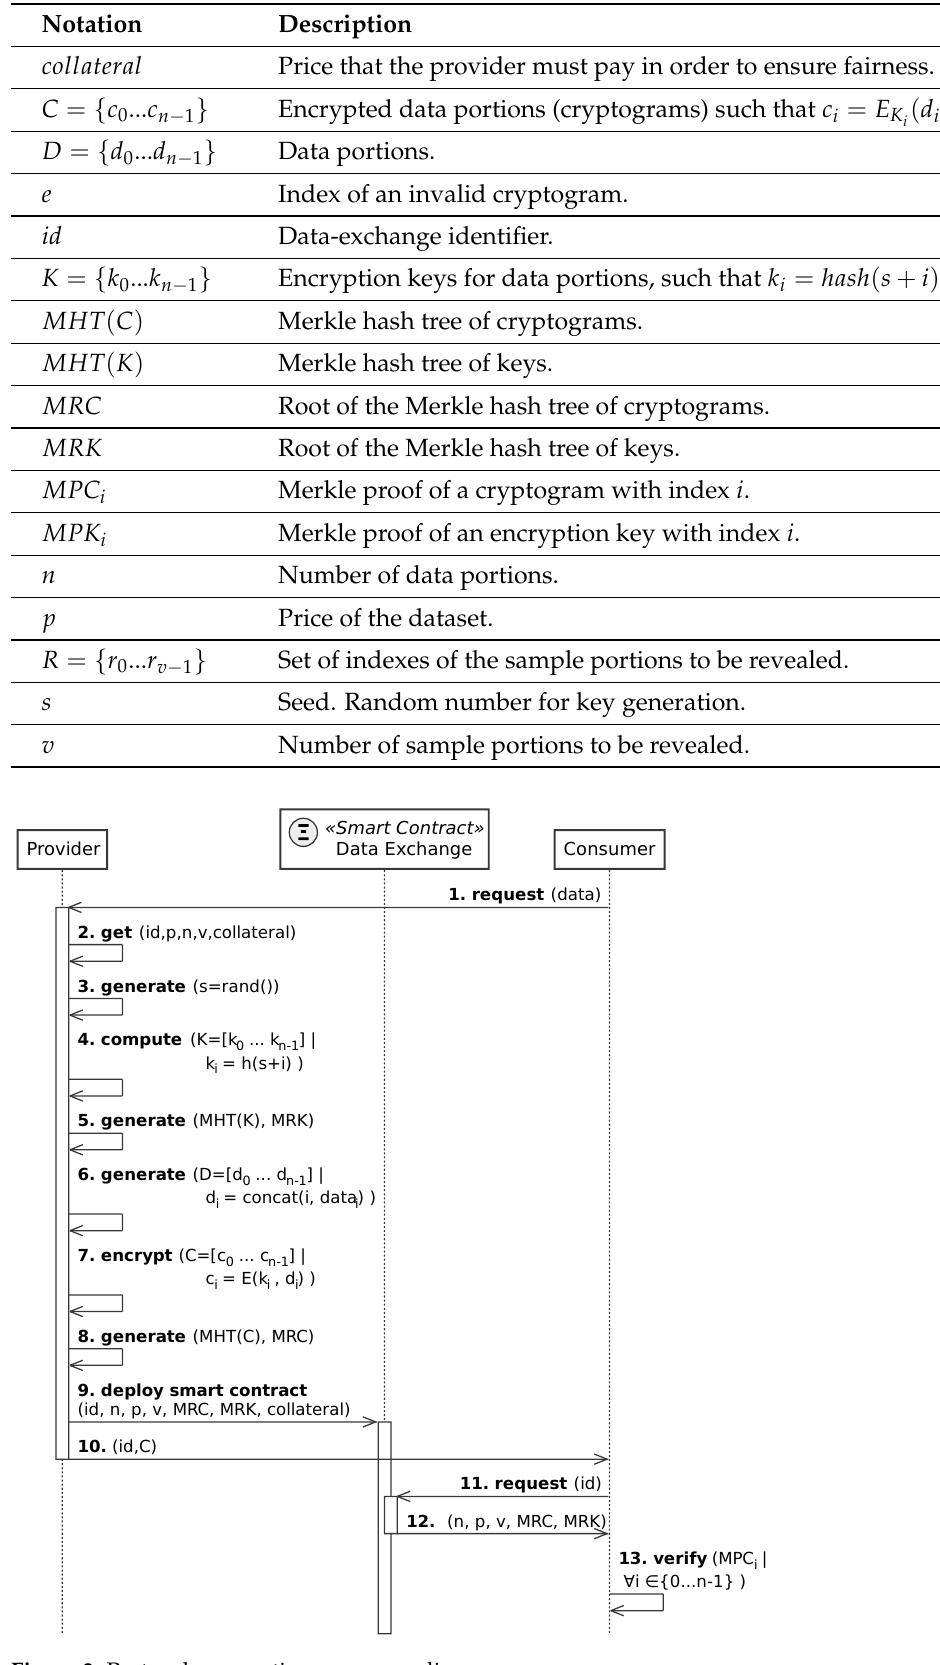
Figure 3. Protocol preparation: sequence